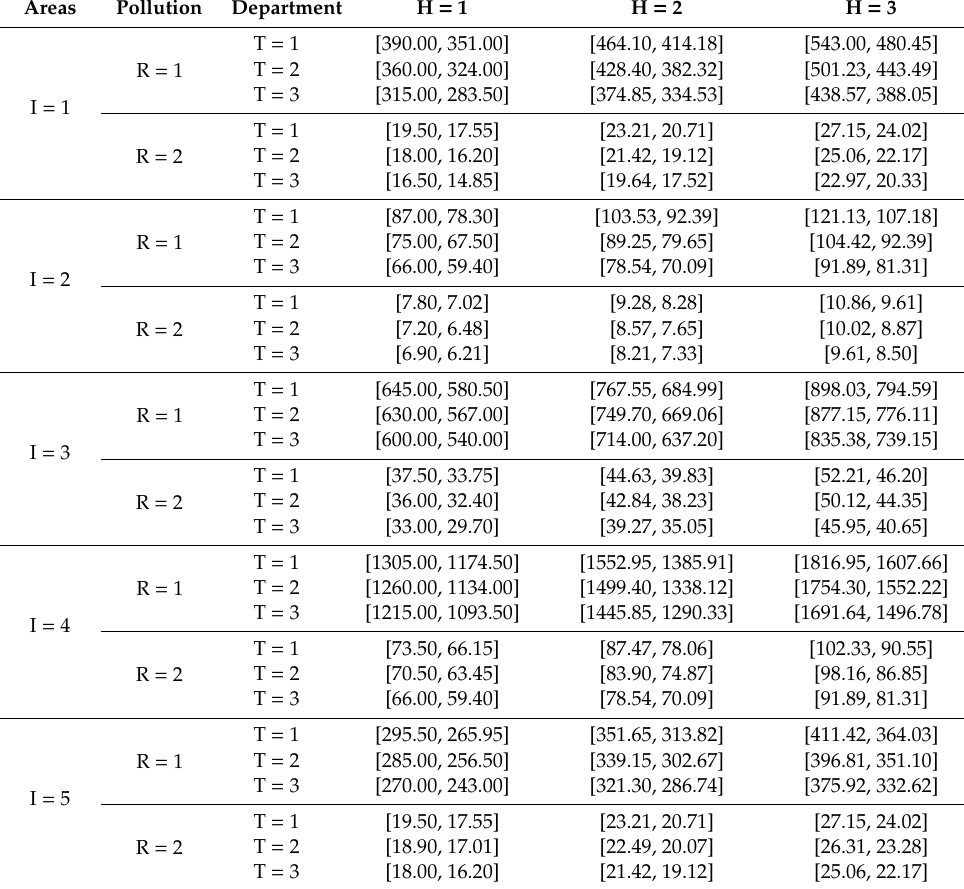
Table 4. The range of pollution-carrying capacity at the level h of the period t (tons / year).